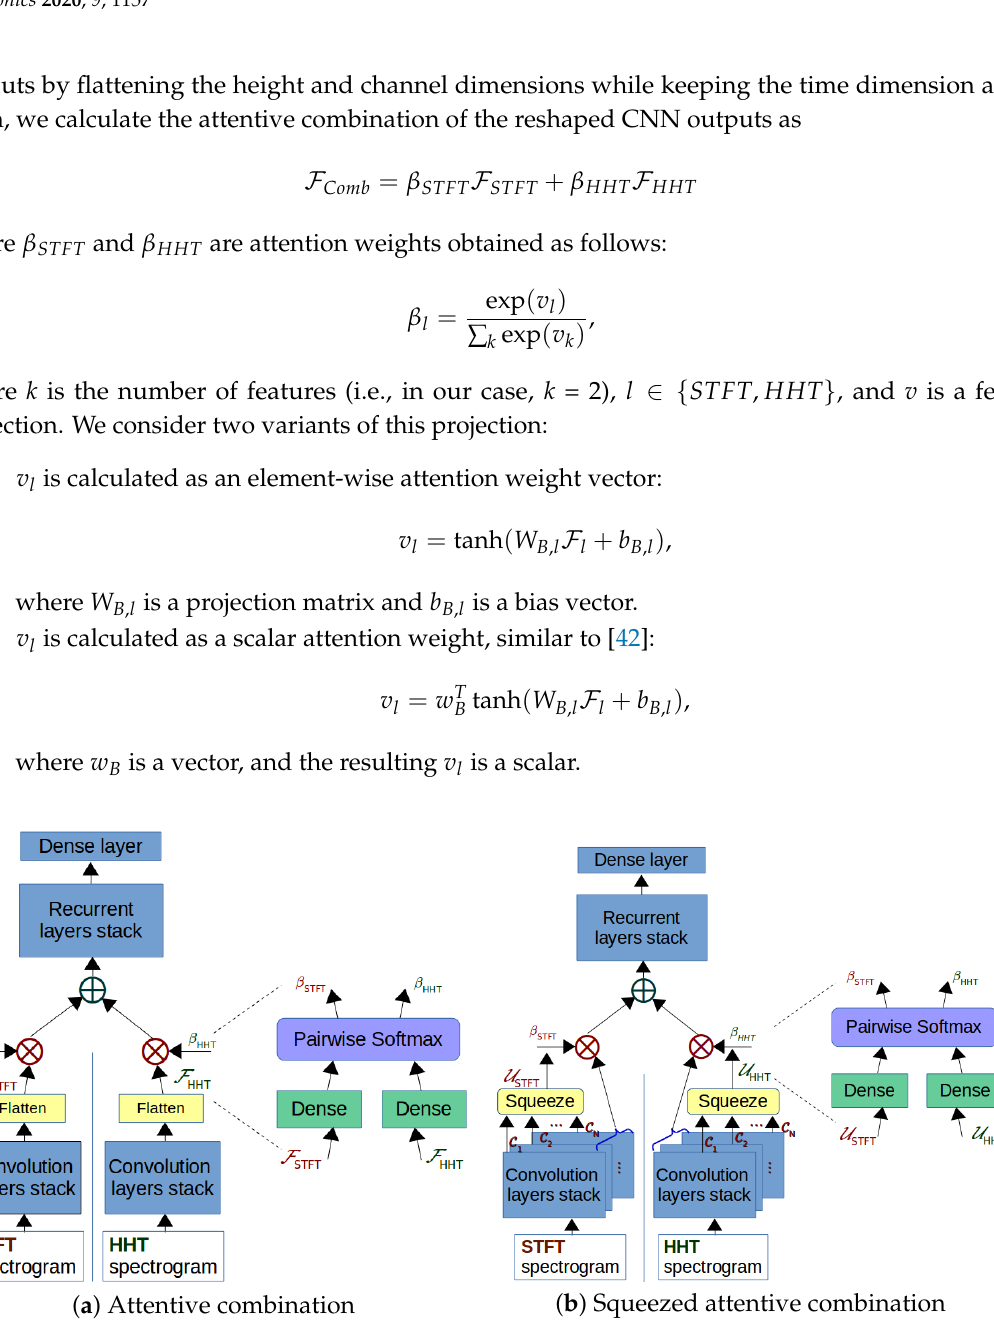
Figure 4. Attention-based feature